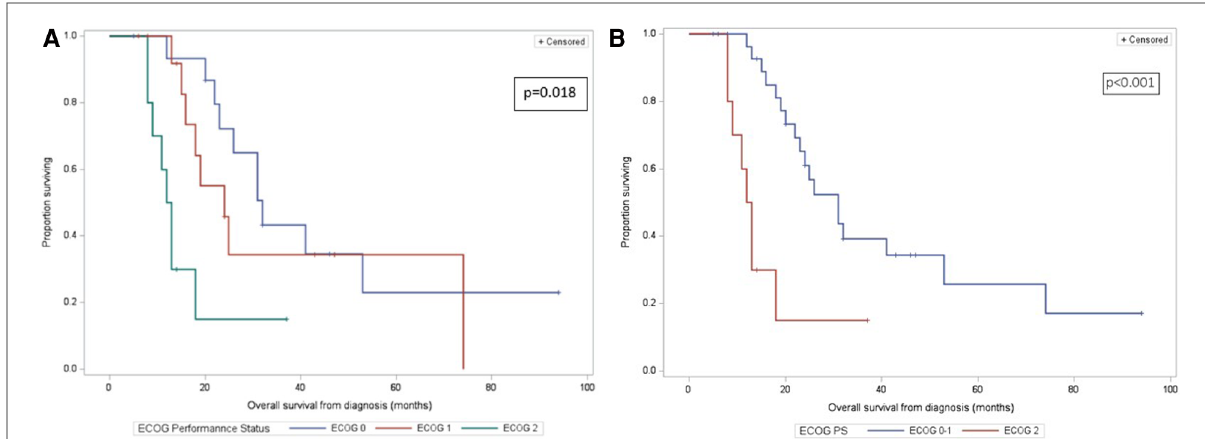
FIGURE 3 ( A ) kaplan-meier overall survival curves of 40 patients who underwent pancreatectomy with PV/SMV resection for BR/LA PC, by ECOG-0/1/2 category. Overall survival is calculated from the time of diagnosis. ( B ) Kaplan-Meier overall survival curves of 40 patients who underwent pancreatectomy with PV/SMV resection for BR/LA PC, by ECOG-0 or − 1 vs. ECOG-2 category. Overall survival is calculated from the time of